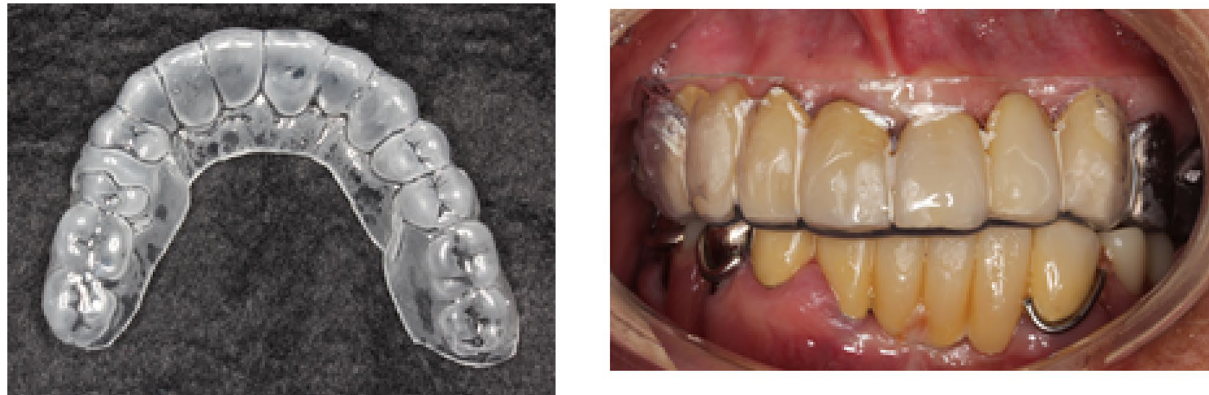
Figure 2. Mouthpiece and its placement in the oral